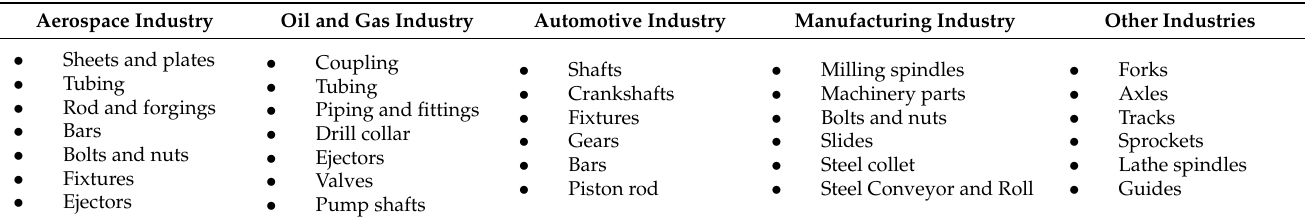
Table 1. AISI 4140 steel application for different kinds of industries